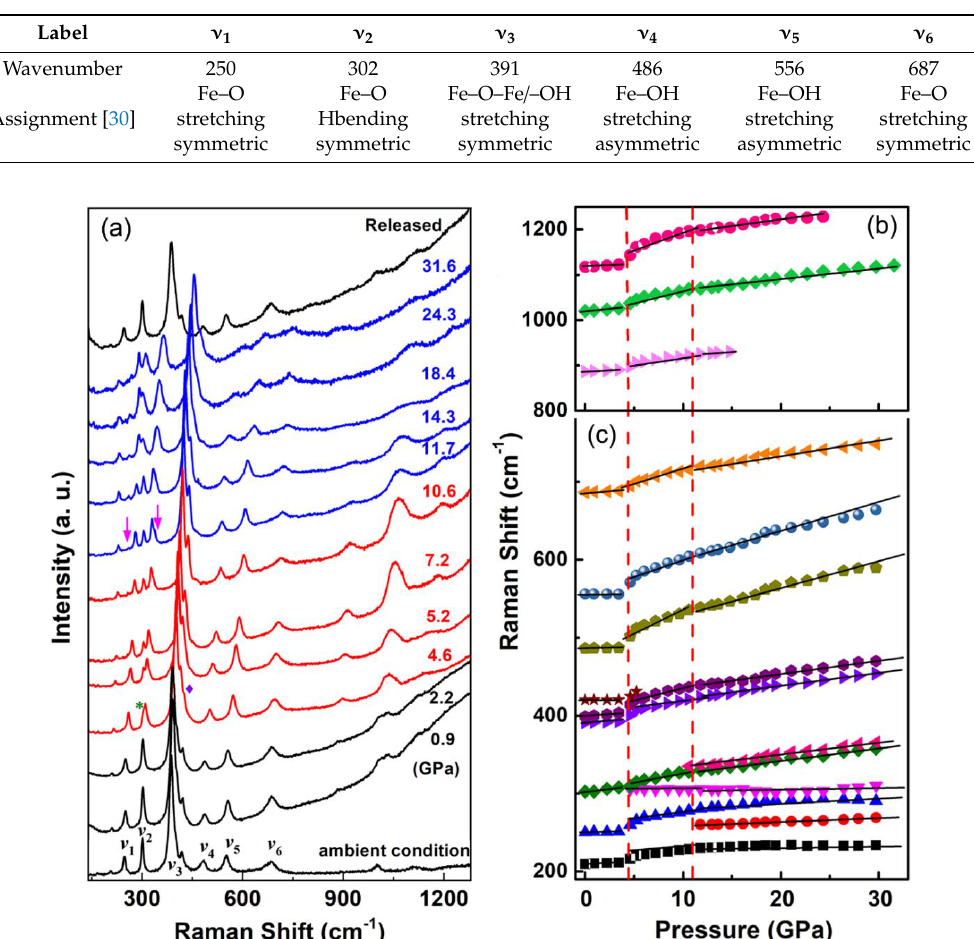
Figure 3. ( a ) Selected Raman spectra of goethite during compression (pressures as labeled) and decompressed back to 0.2 GPa. Assignments for peaks labeled with ν i are listed in Table 1. The star and arrows indicate where a new peak emerges, and the diamond indicates peak disappearance. ( b ) and ( c ) are positions of the Raman peak as a function of pressure. Vertical lines indicate where some major feature changes occur .